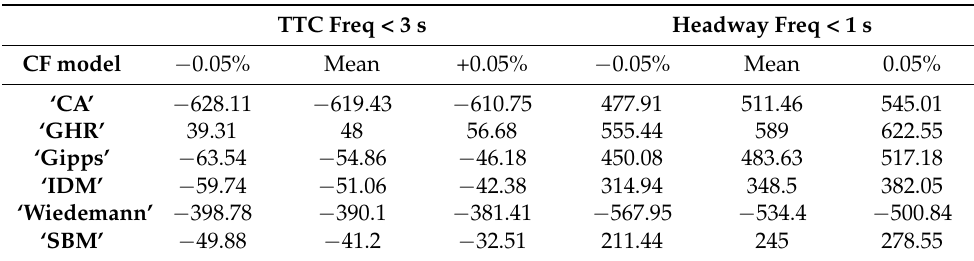
Table 3. t -Test results for each CF model’s critical number of TTCs against observed, significance level 95%.